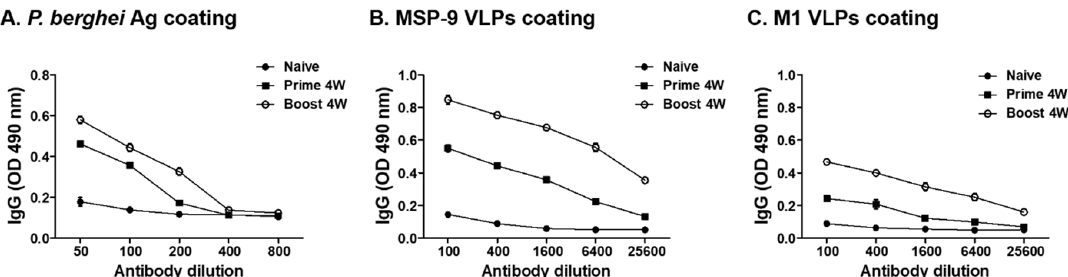
Figure 2. IgG antibody response upon intramuscular immunization with MSP ‐ 9 VLPs. Mice sera were collected twice at a 4 ‐ week interval after prime and boost immunization with MSP ‐ 9 VLPs. A significant increase in the P. berghei ‐ specific IgG antibody level was found in MSP ‐ 9 VLP ‐ immunized mice after prime and boost compared to non ‐ immunized mice ( A ). MSP ‐ 9 VLP ‐ immunized sera also reacted highly to MSP9 ‐ VLPs ( B ) and M1 VLPs ( C ).